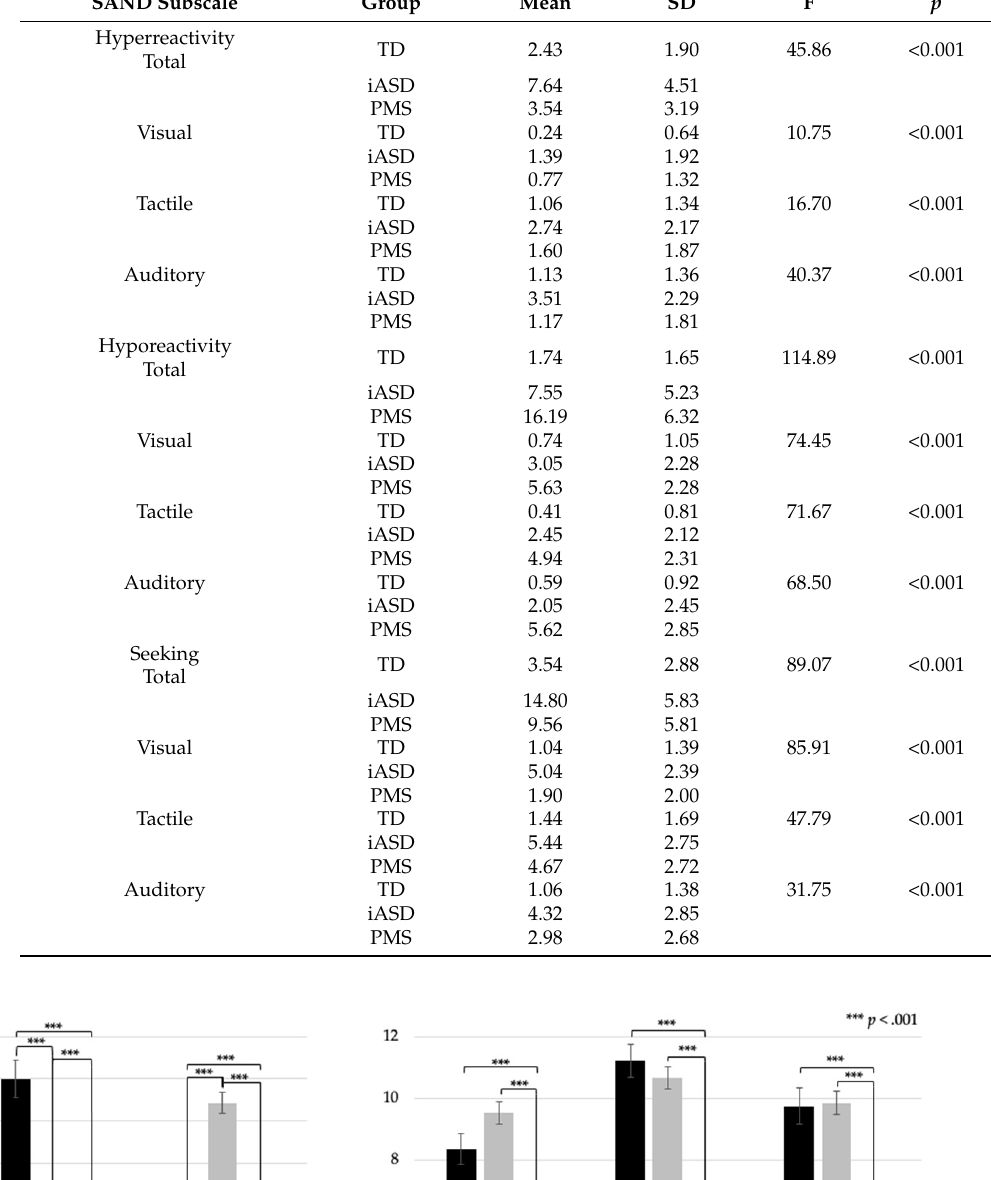
Table 2. Differences in SAND scores between groups. F and p values represent results from the MANOVA.